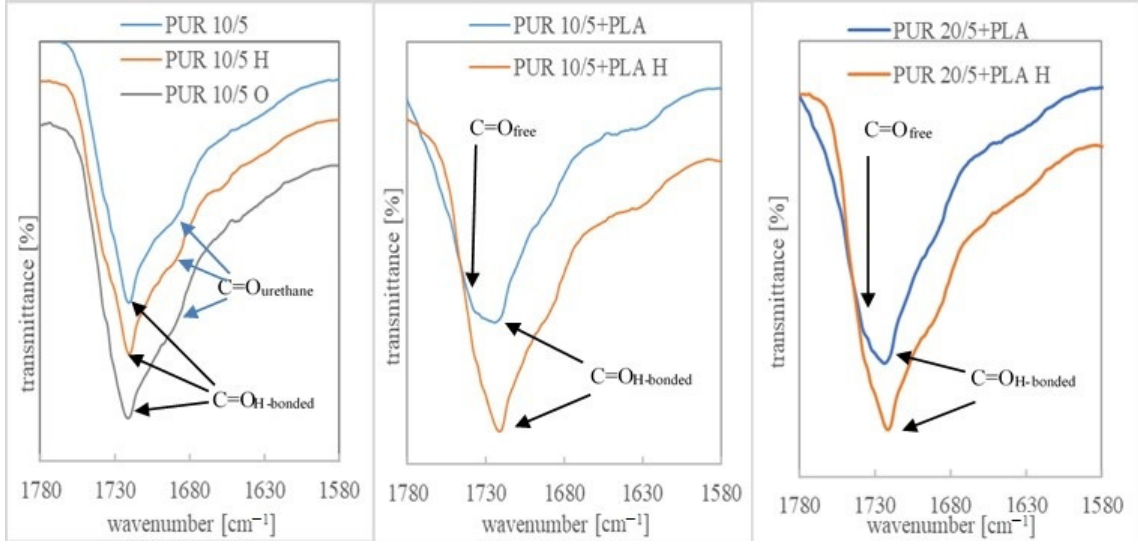
Figure 4. ATR-FTIR spectra in the range 1580-1780 cm − 1 of PUR 10/5, PUR 10/5+PLA and PUR 20/5+PLA, before and after degradation in hydrolytic (36 weeks) and oxidizing (7 weeks) solutions.